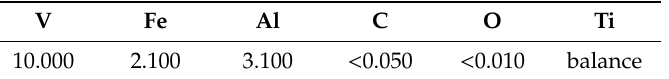
Table 1. The nominal chemical composition of Ti-10V-2Fe-3Al (wt.%).